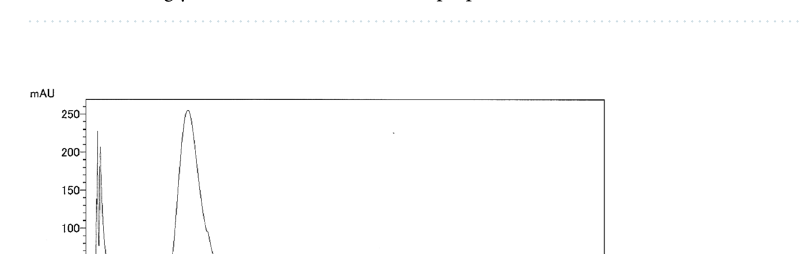
Table 1. Anti-glycation activites of fractions prepared from water extract of corn silk.